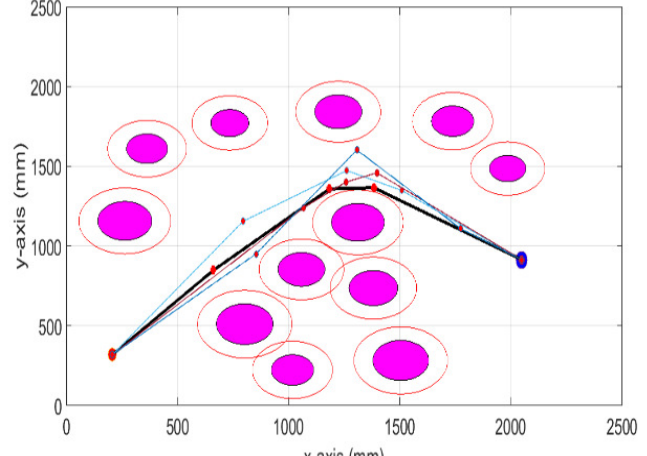
Fig. 16. Path Found by GWO Algorithm for Case 3. Table 2, Comparison of the Shortest path length and the time of execution of the GWO